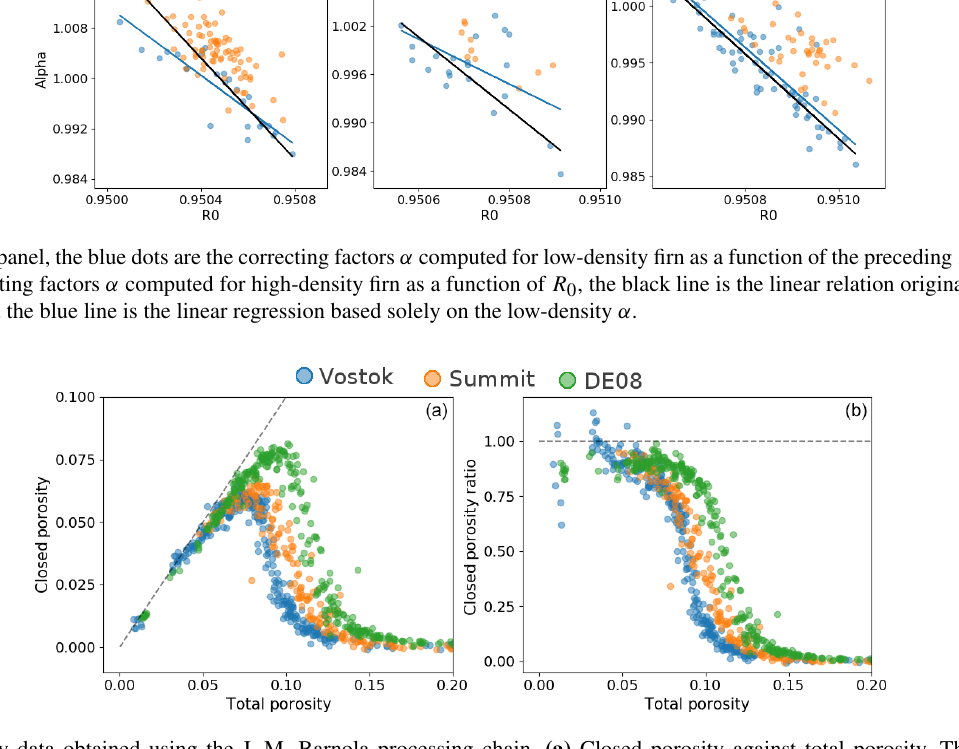
Figure 2. Porosity data obtained using the J.-M. Barnola processing chain. (a) Closed porosity against total porosity. The dashed line represents where the closed porosity equals the total porosity. (b) Closed porosity ratio over total porosity. The dashed line indicates where the closed porosity ratio equals